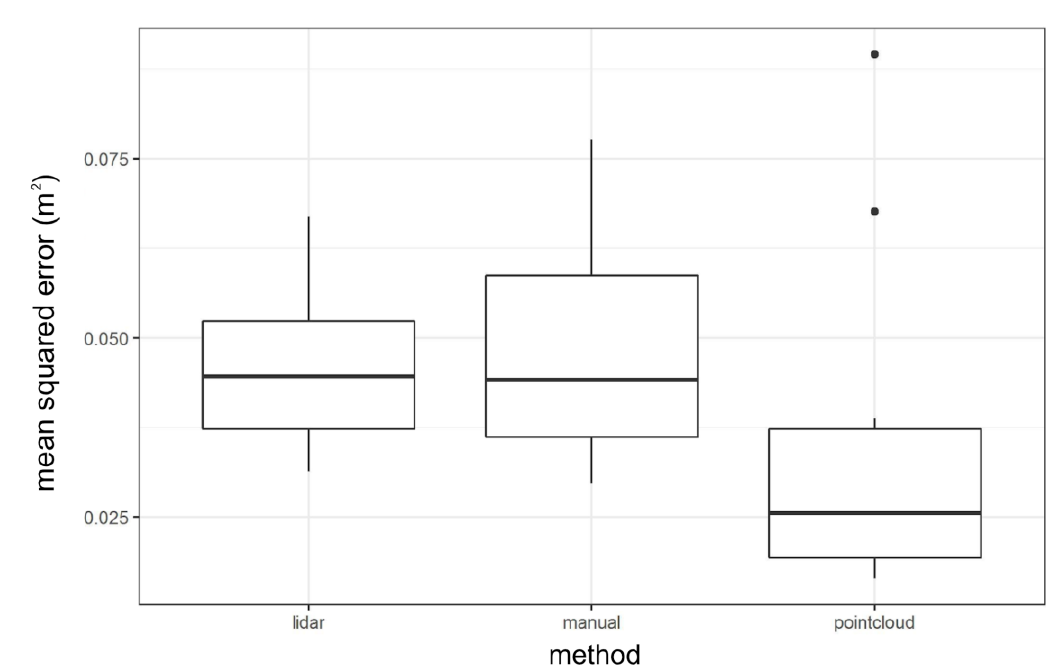
Figure 5. Distribution of regression model mean squared error from 10-fold cross-validation results across three di ff erent vegetation height prediction methods.